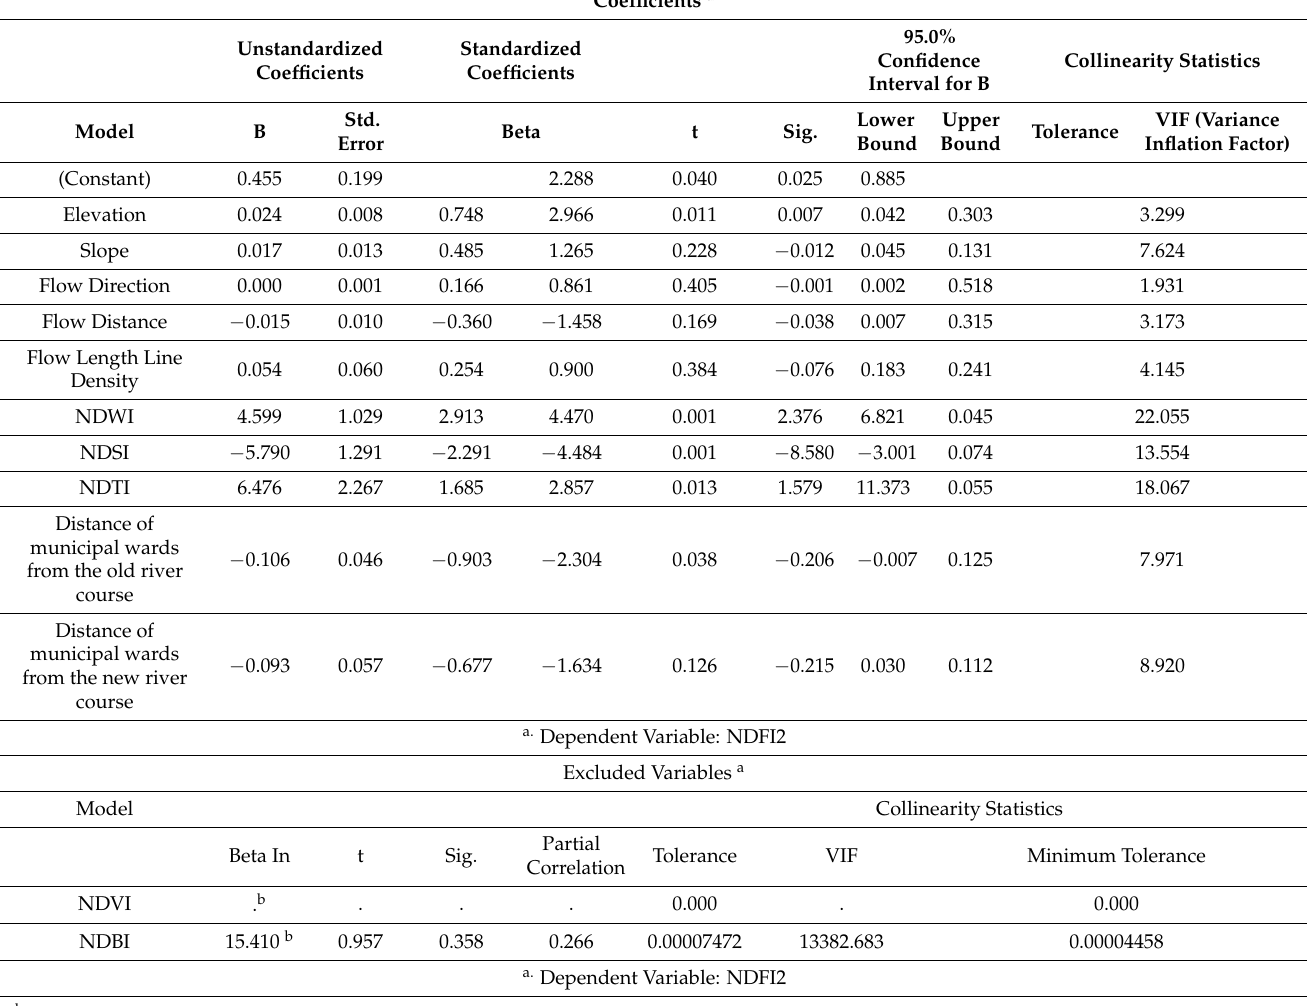
Table 11. Coefficients of the regression analysis